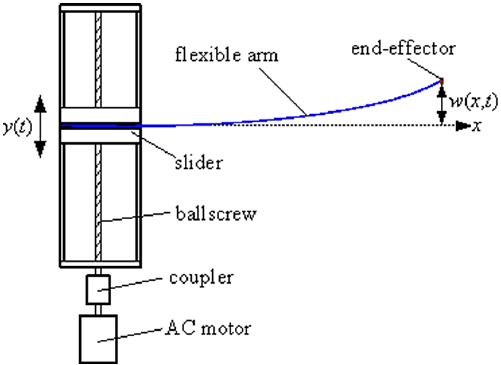
Figure 1. Schematic diagram of the